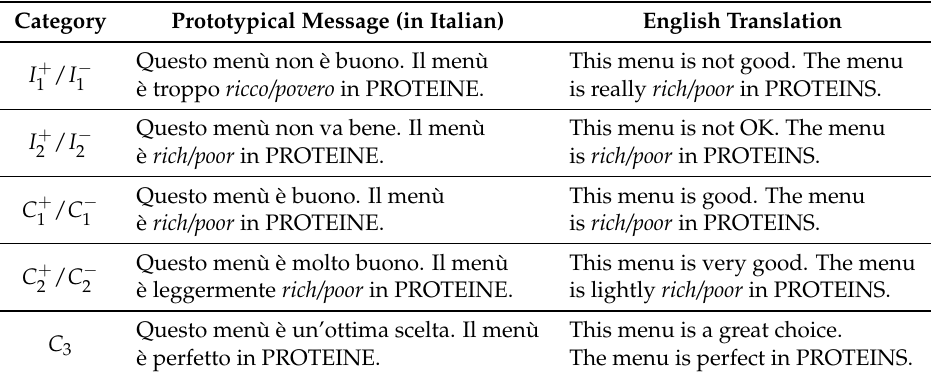
Table 1. The prototypical messages describing the STP reasoner classification for the energy value for the proteins. The italicized text varies according to the + / − deviation; the uppercase text corresponds to the considered